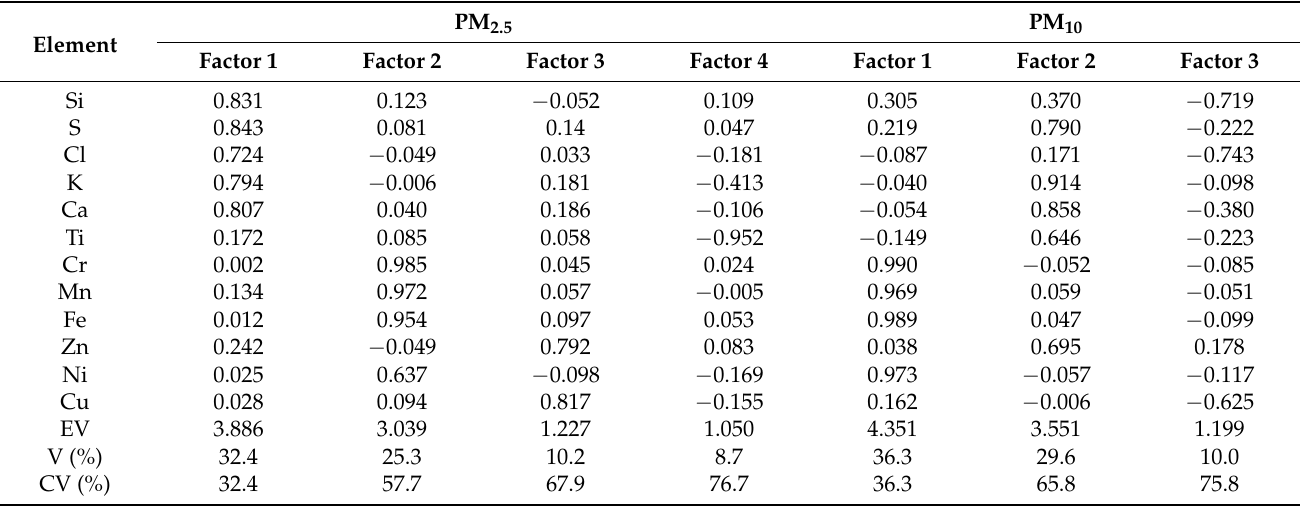
Table 8. Summary of principal component analysis (PCA) of elements in PM 2.5 and PM 10 in Pathum Thani Province.